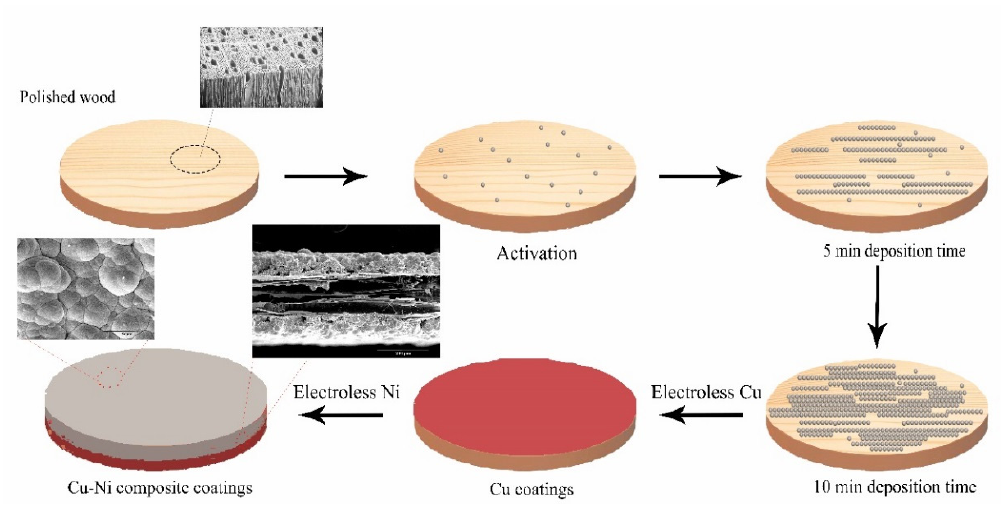
Figure 9. Schematic illustration of electroless Cu–Ni process.